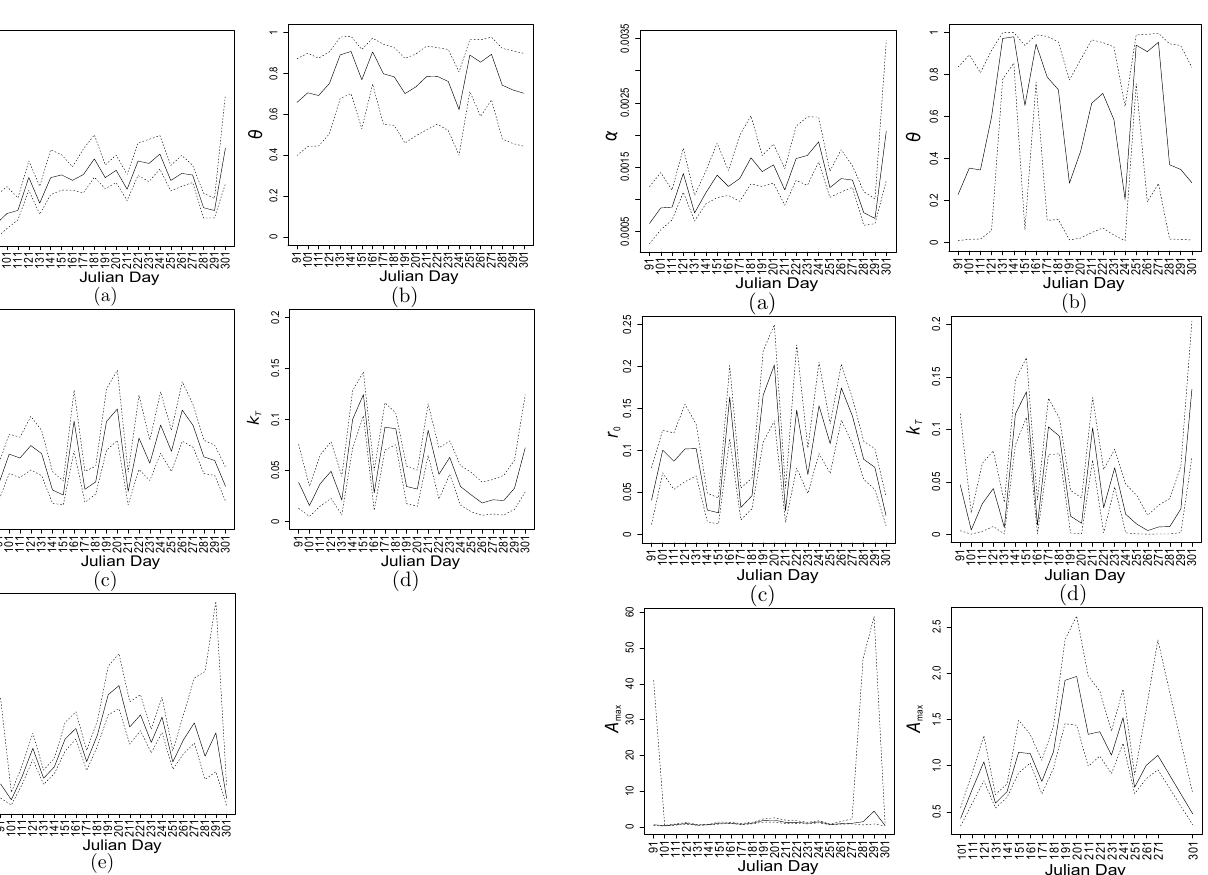
Figure 6. Median (solid lines) and 95% credible intervals (dashed lines) of the posterior distributions of the NRH parameters when using informative prior distributions for each 10-day block during the growing season in 2009. The x axis is the first Julian day of each 10-day block. The y axis represents NRH parameter. Information about the NRH parameters is given in Table 1.